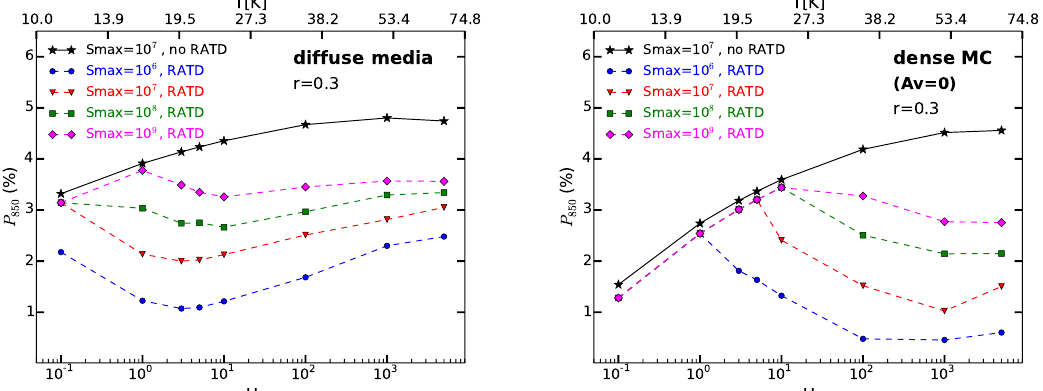
Figure 17. Polarization degree at 850 µ m as a function of the radiation strength ( U ) or grain temperature ( T d , top horizontal axis) for two cases, without RATD (solid lines) and with RATD (dashed lines), assuming the different tensile strength of grains in the diffuse ISM (left panel) and MC (right panel). Grains with axial ratio of r = 1/3 are considered. From Lee et al.